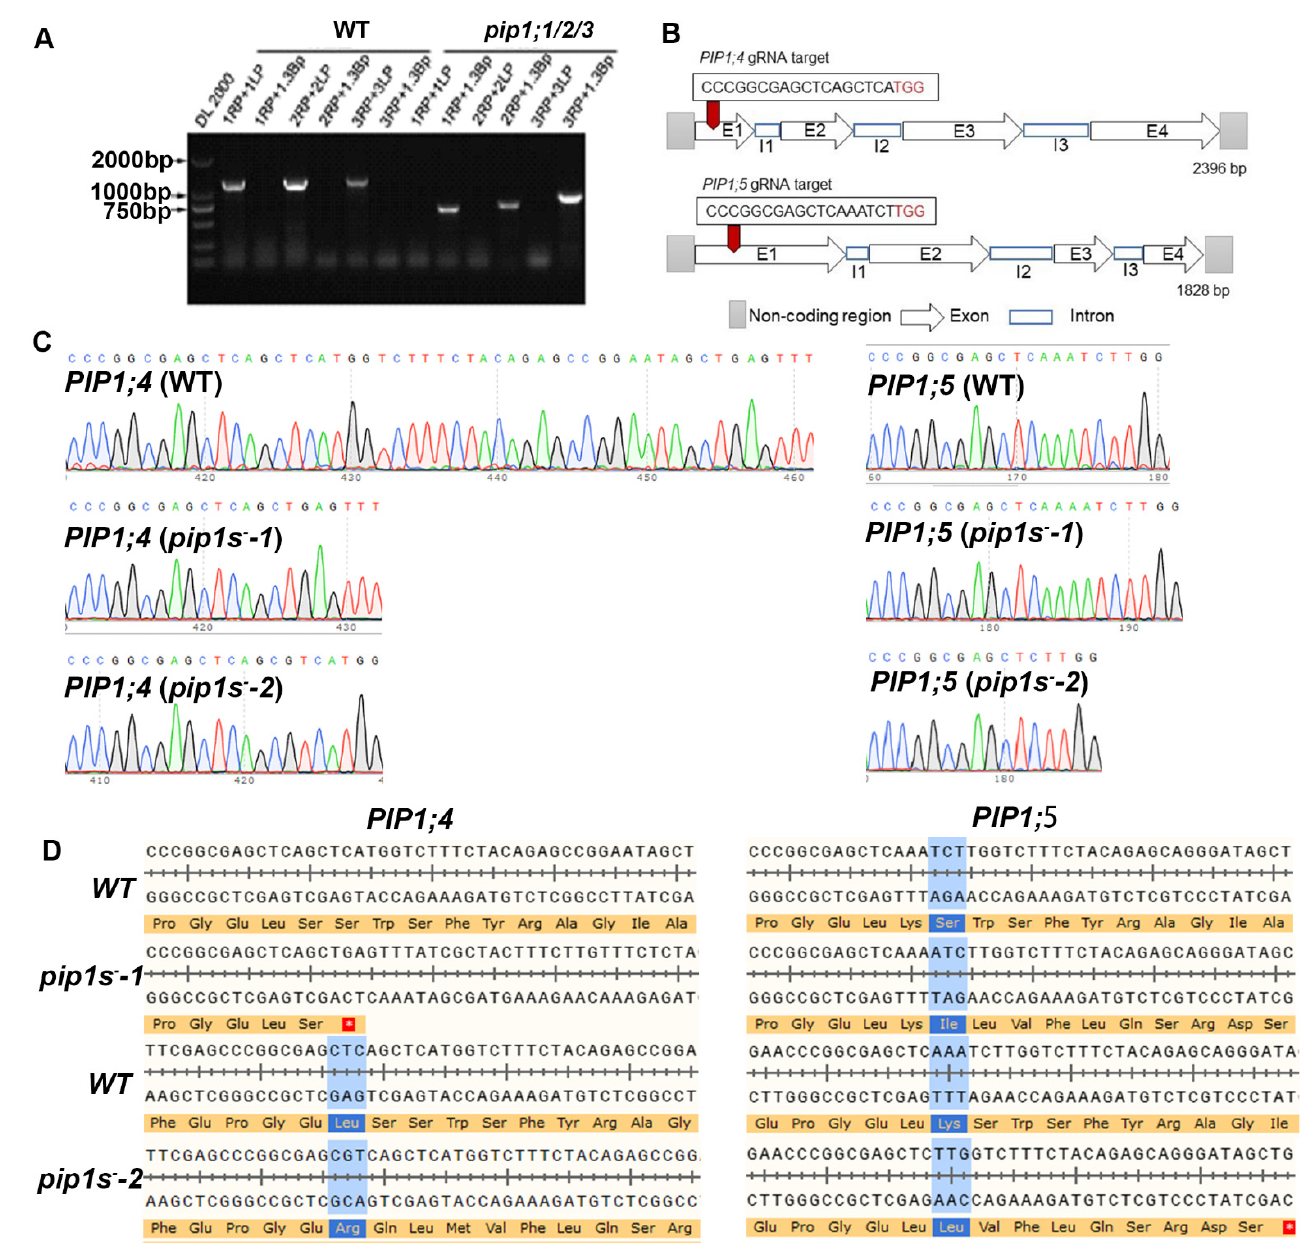
Figure 1. Generation of the pip1s mutants. ( A ) Amplification of the T-DNA insertion in mutant pip1;1/2/3 . ( B ) Schematic of the pip1s mutant. ( C ) Sanger sequencing chromatographs showing the deletion in the pip1s mutant. ( D ) Amino acid sequence alignment of the pip1s – mutant and the WT plant. The asterisk on the red background represents the termination codon.